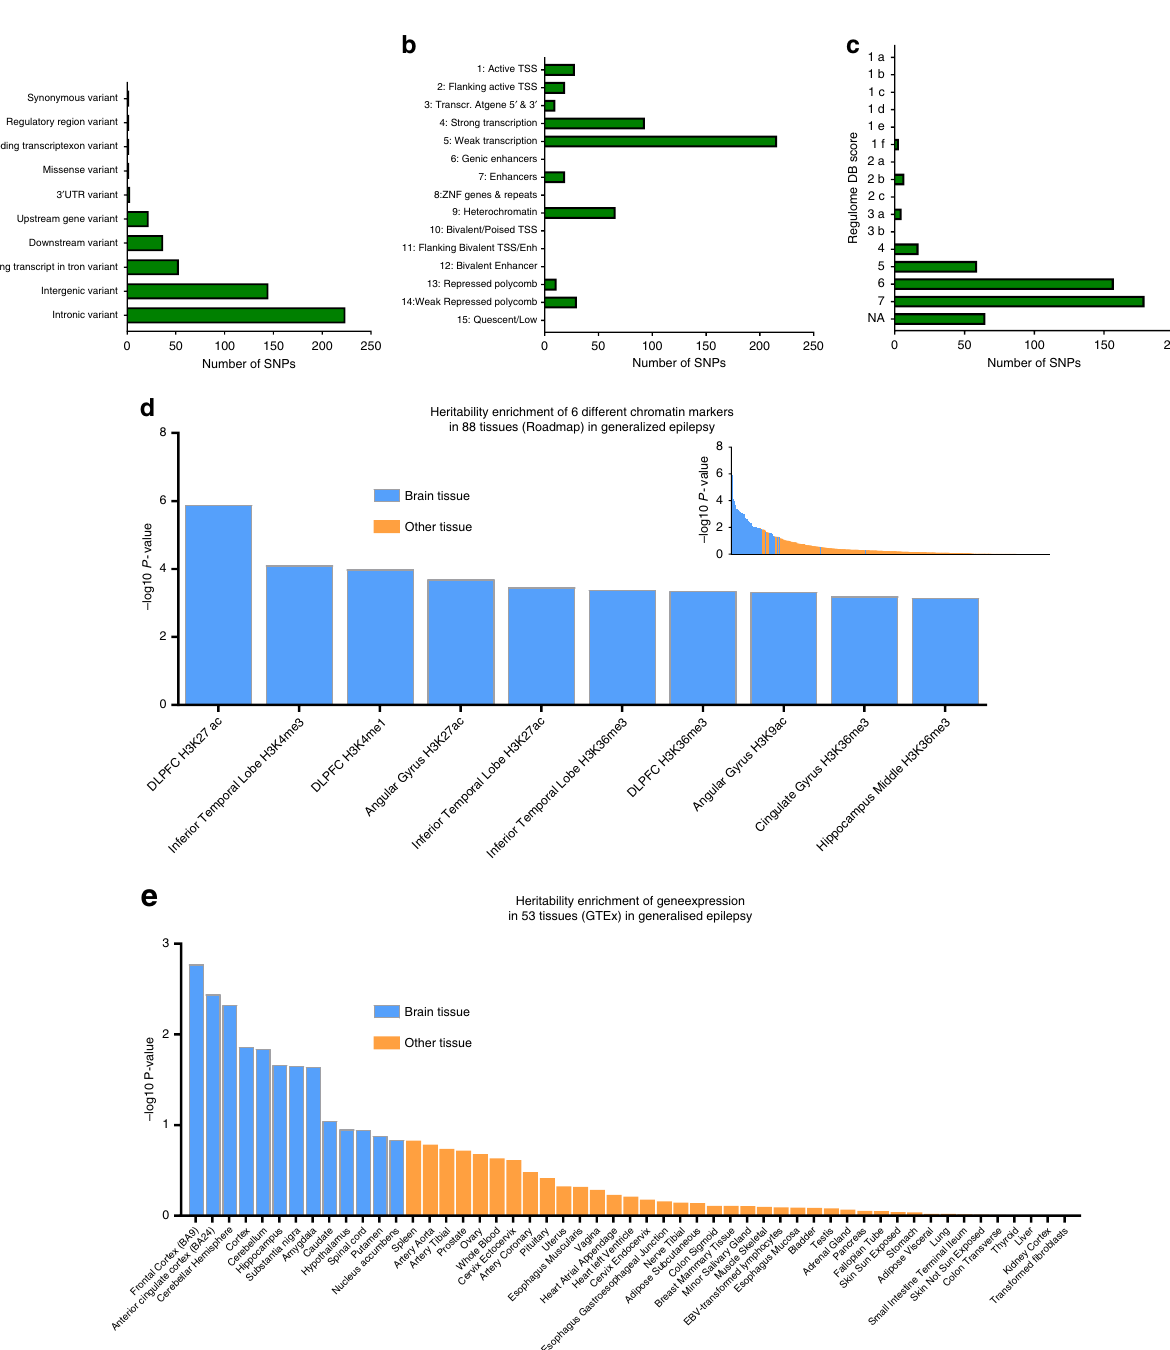
Fig. 3 Functional annotation and heritability enrichment of epilepsy GWAS results. a functional categories of all genome-wide signi fi cant SNPs in all phenotypes. b Minimum (most active) chromatin state across 127 tissues for all genome-wide signi fi cant SNP in all phenotypes; TSS - transcription start site. c The RegulomeDB score for all genome-wide signi fi cant SNPs in all phenotypes, where 7 represents no evidence for affecting regulation and lower scores represent increasing evidence; NA - the variant does not exist in RegulomeDB. d Heritability enrichment for genetic generalized epilepsy with 6 different chromatin markers in 88 tissues, calculated with strati fi ed LD-score regression using data from the Roadmap Epigenomics Project. The main bar chart represent the 10 tissues with the strongest heritability enrichment and the inset shows the full distribution of all chromatin markers in all tissues. e Heritability enrichment of genes expressed in 53 tissues, calculated with strati fi ed LD-score regression using data from the gene-tissue expression (GTEx) Consortium H3K27ac and H3K4me1 are epigenetic markers associated with generalized epilepsy with genes expressed in Brodmann Area 9 regulating gene transcription, suggesting that altered transcrip- (strati fi ed LD-score regression; p = 1.56 × 10 − 6 ), which encom- passes the dorsolateral prefrontal cortex (Fig. 3e). These fi ndings tion in the dorsolateral prefrontal cortex could be one of the further corroborate our TWAS results (using data from the underlying mechanisms of epilepsy. This is further supported by unrelated CommonMind Consortium database), which shows a tissue-speci fi c heritability enrichment analysis (using data from signi fi cant associations of epilepsy with gene expression of several the GTEx Consortium), showing strongest enrichment for genetic NATURE COMMUNICATIONS| (2018) 9:5269 |DOI: